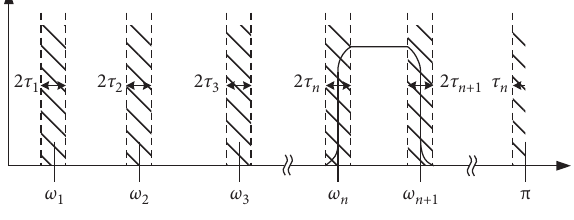
Figure 1: Frequency band